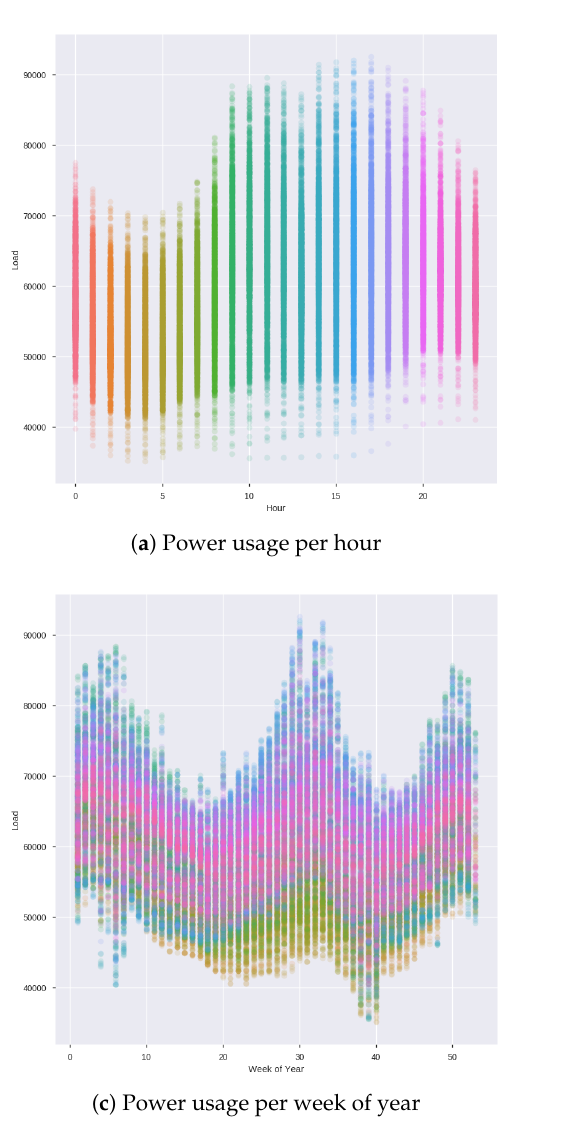
Figure 8. Trends of power usage.